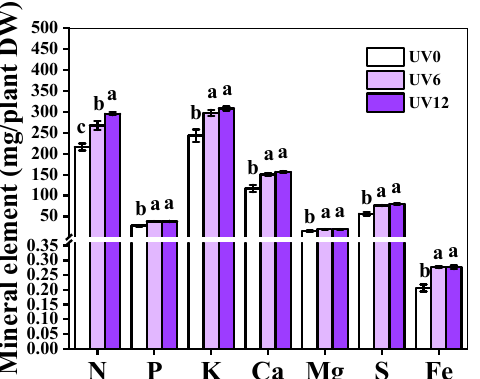
Figure 6. Mineral element accumulations of Chinese kale subjected to different durations of UVA- radiation exposure. Different lowercase letters (a–c) labeled on the vertical bar (means ± standard n = 3) represent significant differences by one-way ANOVA with multiple-range tests ( p